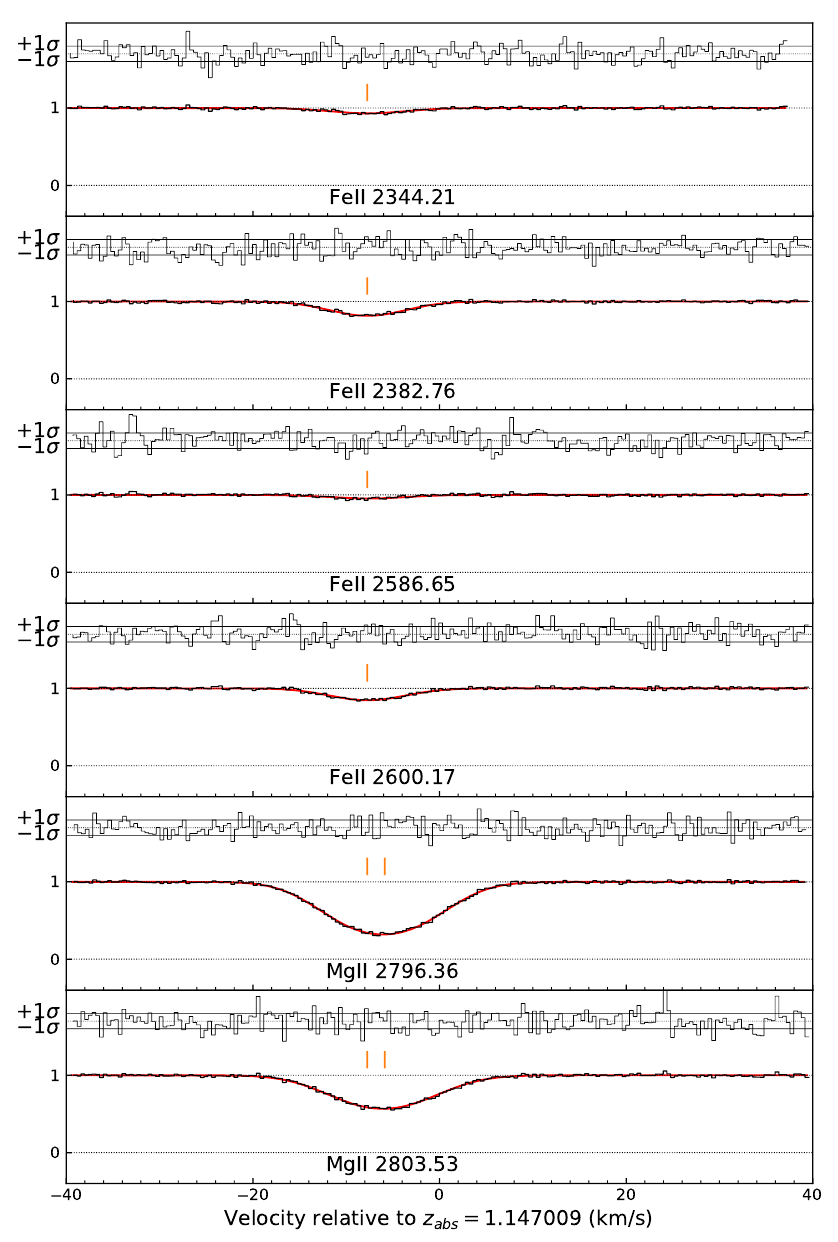
Figure 2. The data (black histogram) in this plot corresponds to the upper panel labelled “Generating model” in Table 1. The model (continuous red curve) corresponds to the middle panel labelled “Fitting (turbulent)”. See Section